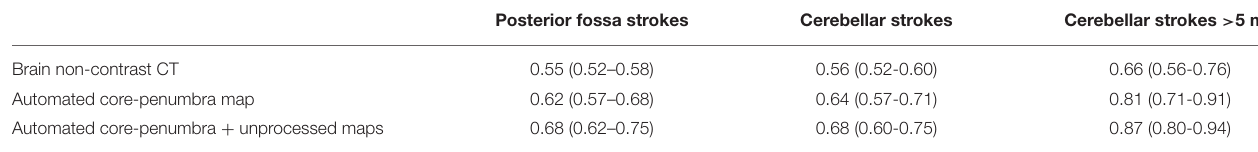
TABLE 3 | Area under the curve (with 95% confidence intervals) for the detection of posterior fossa strokes for different imaging